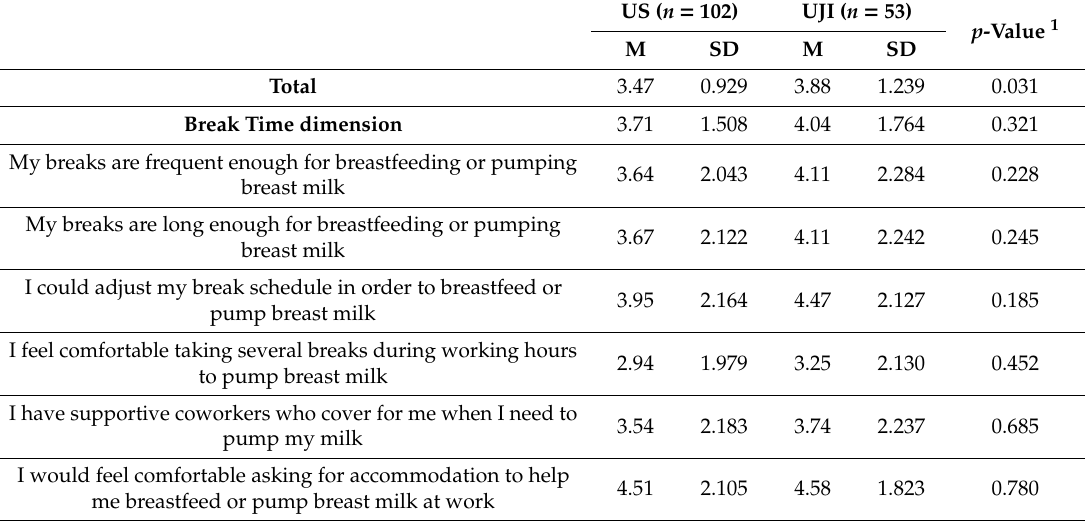
Table 4. Results obtained with the Workplace Breastfeeding Support Scale. Comparison of universities ( n =